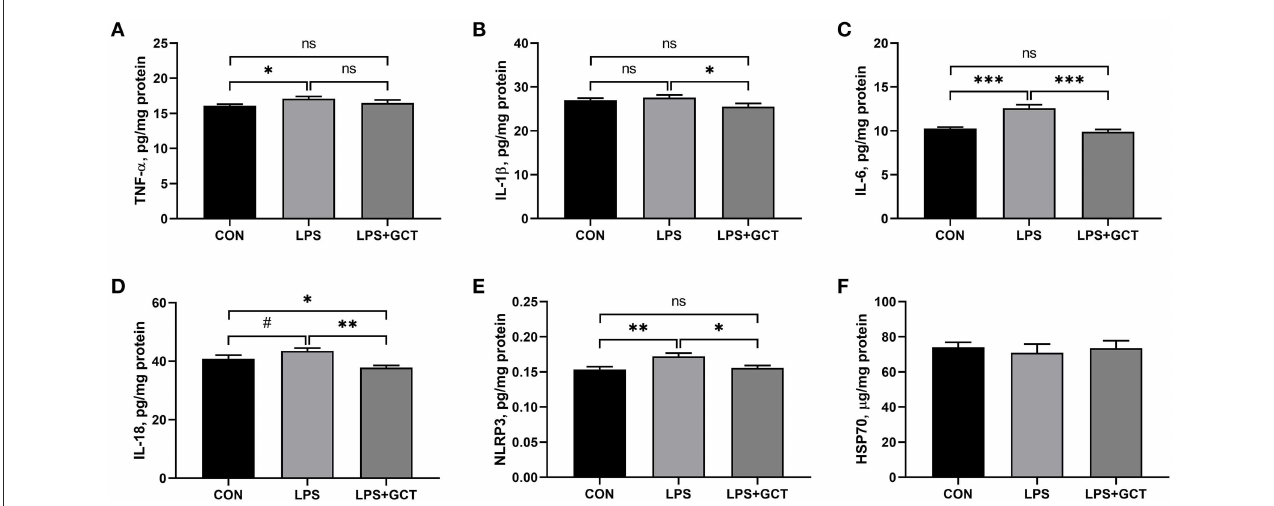
FIGURE5 Effects of dietary Galla Chinensis tannin (GCT) supplementation on hepatic inflammatory cytokines of broilers under lipopolysaccharide (LPS)-challenge. (A) Tumor necrosis factor- α (TNF- α ); (B) Interleukin-1 β (IL-1 β ); (C) Interleukin-6 (IL-6); (D) Interleukin-18 (IL-18); (E) NLRs family pyrin domain containing 3 (NLRP3); (F) Heat shock 70 kDa protein (HSP70). CON, fed on a basal diet and intraperitoneally injected with saline solution; LPS, fed on a basal diet and intraperitoneally injected with LPS; LPS + GCT, fed on a basal diet supplemented with 300 mg/kg GCT and intraperitoneally injected with LPS. Values are